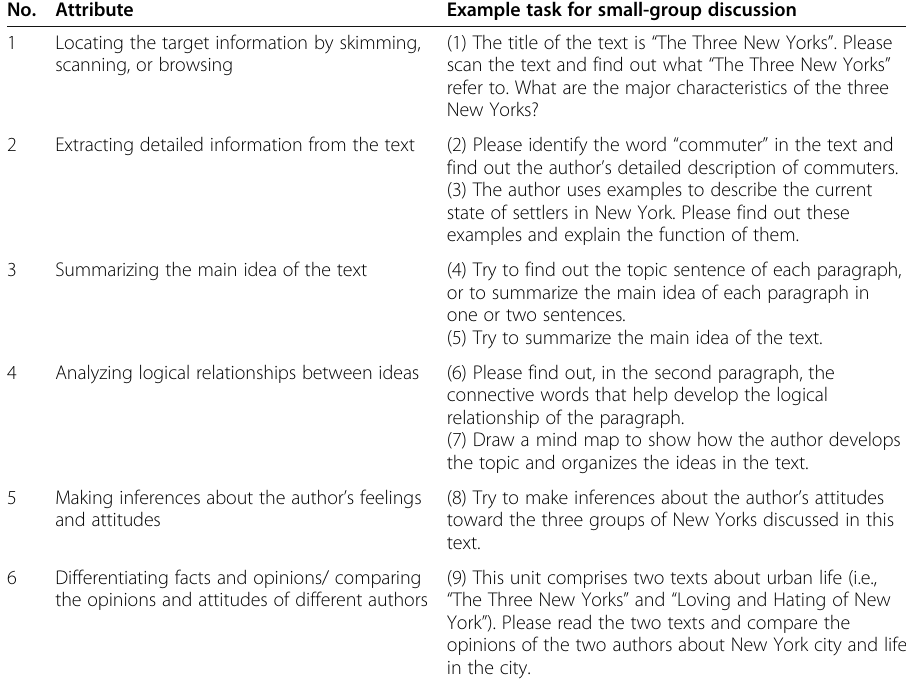
Table 5 Examples of reading tasks for small-group discussion in the classroom No. Attribute Example task for small-group